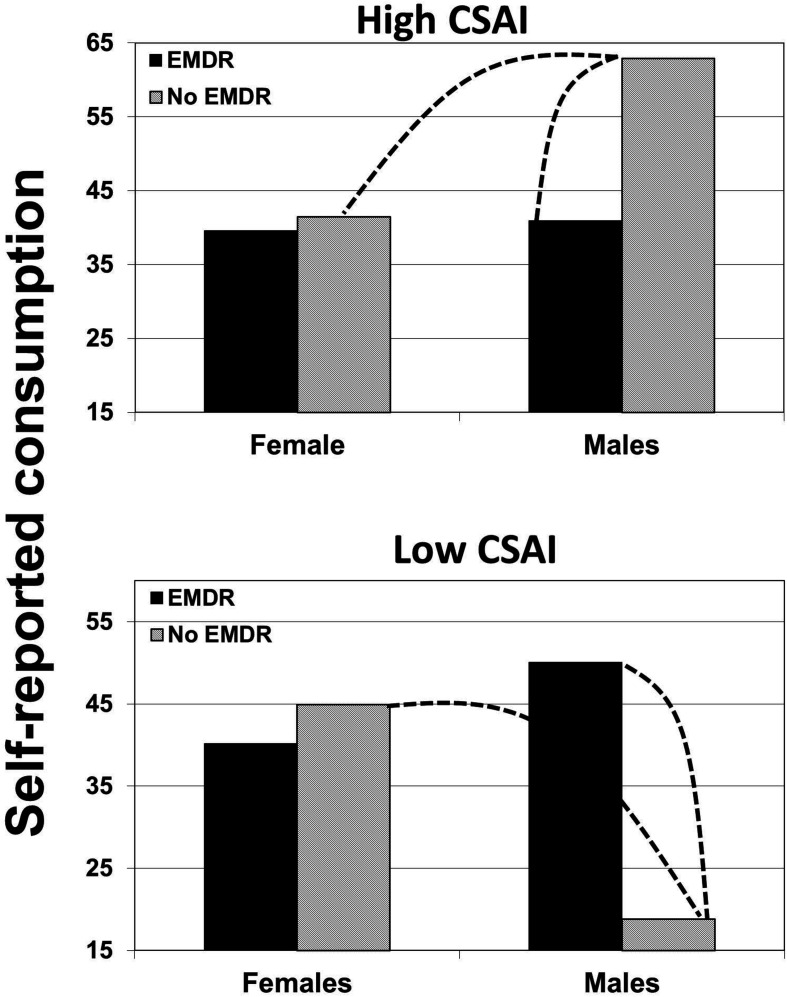
The effects of induced eye movements (EMi) on self-reported fruit and vegetable consumption, moderated by CSAI and gender (the dotted line indicates a significant difference).